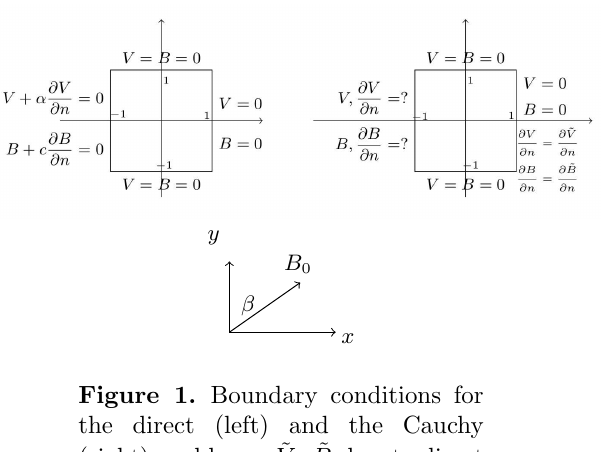
Figure 1. Boundary conditions for the direct (left) and the Cauchy (right) problems. ˜ V , ˜ B denote direct problem